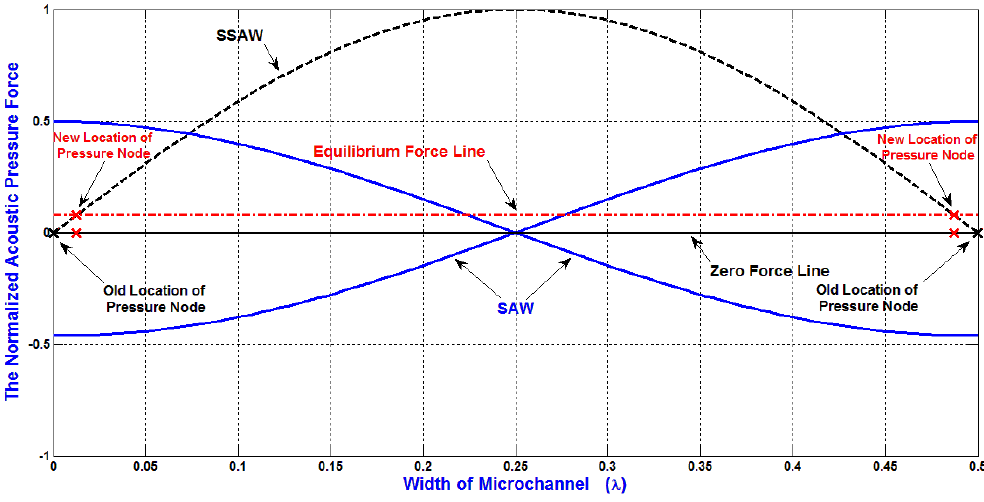
Figure 3. The attenuation effect on the equilibrium force line and the locations of the pressure nodes.